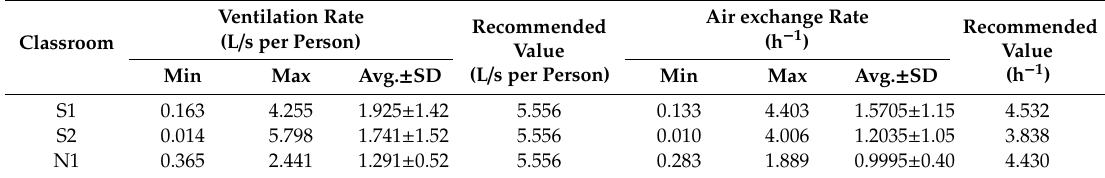
Table 6. Ventilation rates and air exchange rate (AER) in